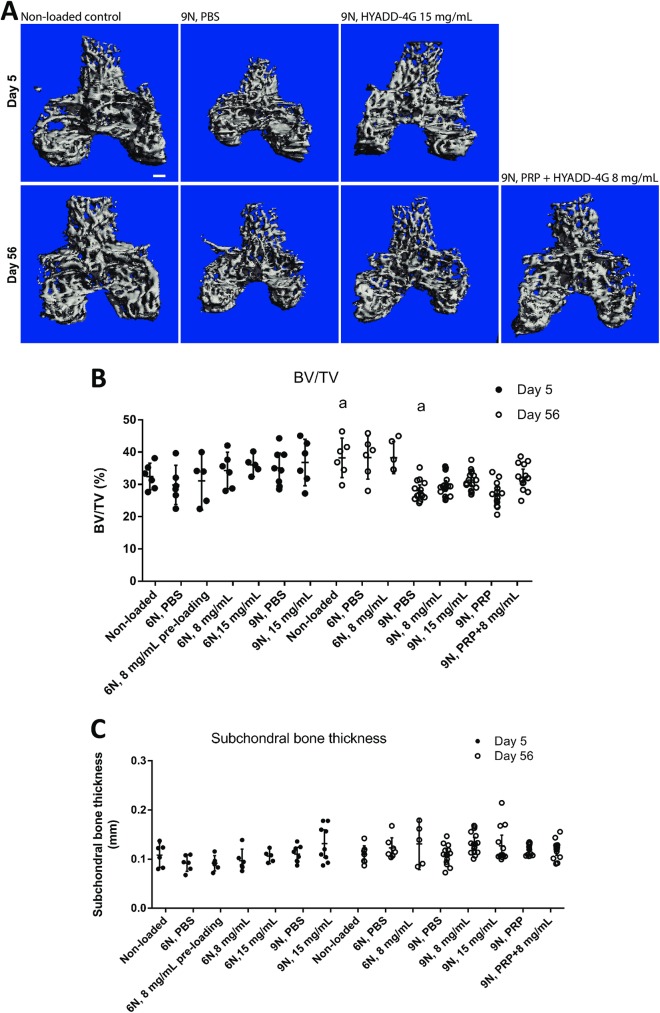
Micro-CT analysis.Micro-CT results showed no preventive effect of treatments on BV/TV at day 56 following loading. Trabecular bone was analyzed at the femoral epiphysis at day 5 (top row) and day 56 (bottom row). All images are presented as superior views (A). Quantification of femoral epiphysis trabecular bone volume (BV/TV) showed that there was no significant difference between treatment groups and the PBS at this time point (B). a: P = 0.02. Interestingly, at day 56 (9N group) receiving Hyadd-4G at 15 mg/mL and PRP + HYADD® 4-G at 8 mg/mL group showed no statistical differences at the 56 days, non-loaded group. Quantification of subchondral bone thickness, showing no preventive effect of treatments on bone loss at 56 days after loading is presented (C). Error bars represent 95% confidence interval. PBS = phosphate buffered saline, PRP = platelet-rich plasma.